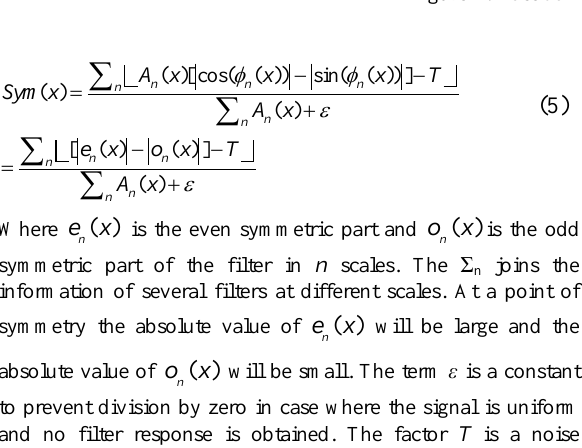
Figure 1. Location map of the six test sites